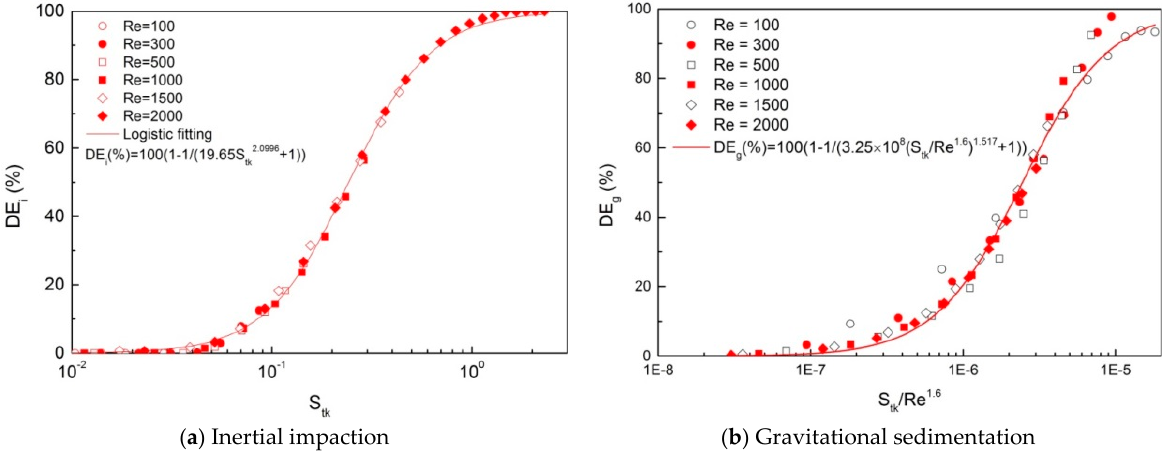
Figure 7. Variation of particle deposition efficiency ( DE ) in terms of non-dimensional parameters: ( a ) S tk for inertial impaction and ( b ) S tk / Re 1.6 for gravitational sedimentation.